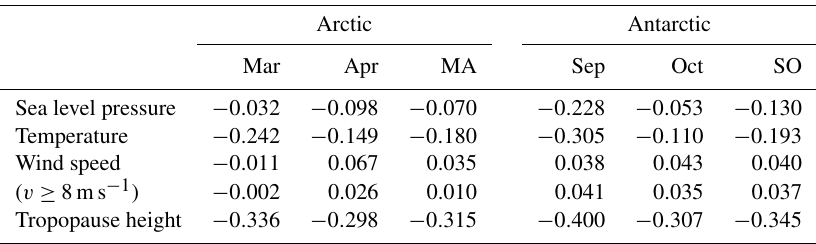
Table 3. Spearman rank correlation coefficients between total BrO VCDs and four meteorological parameters. The results are shown separately for different months in spring in the Arctic and Antarctic. Note that all Spearman rank correlation coefficients are significant